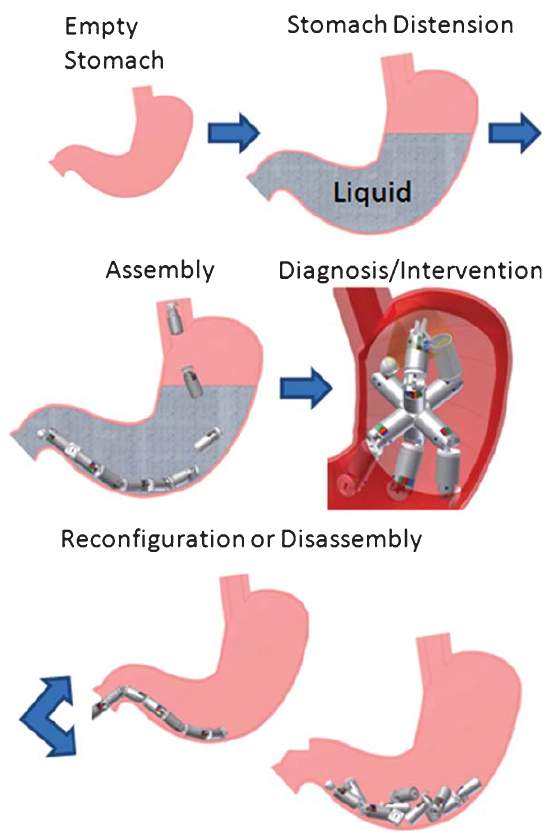
Fig. 1. An assembling reconfigurable endoluminal surgical (ARES)